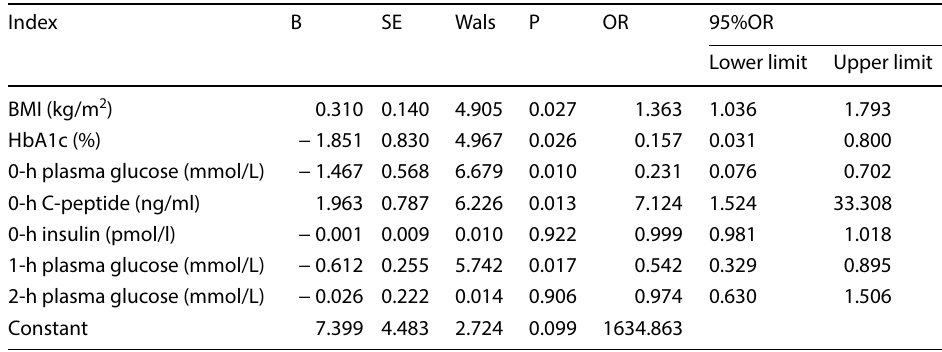
Table 2 Multiple logistic regression analysis of factors affecting the occurrence of